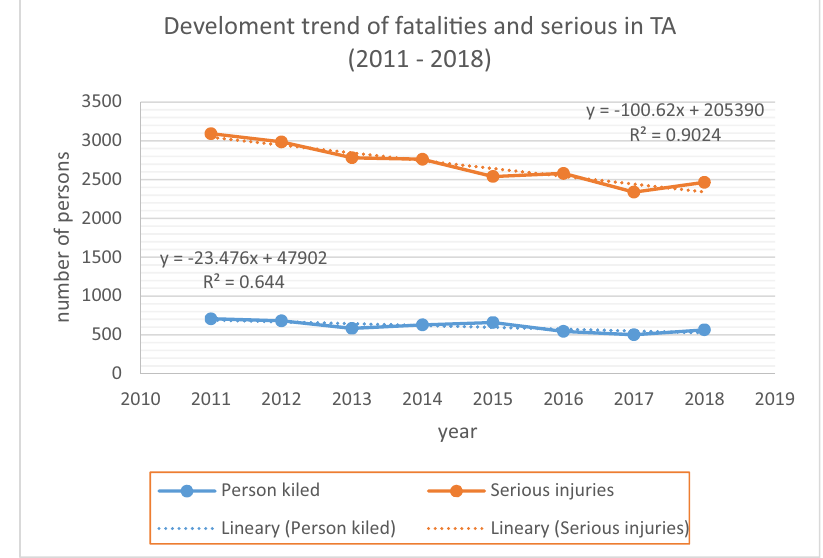
Figure 2: The trend in the number of fatalities and severe injuries as a result of TAs in the period 2011 – 2018.